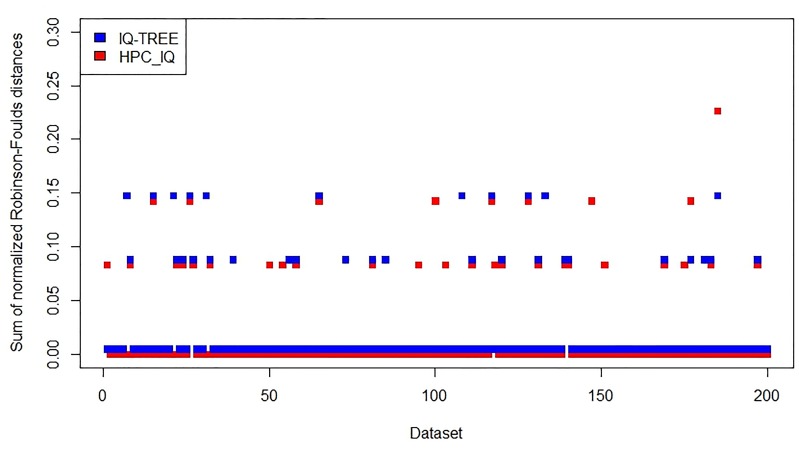
Accuracy assessment of IQ-TREE and HPCIQ on 200 Narrow datasets.